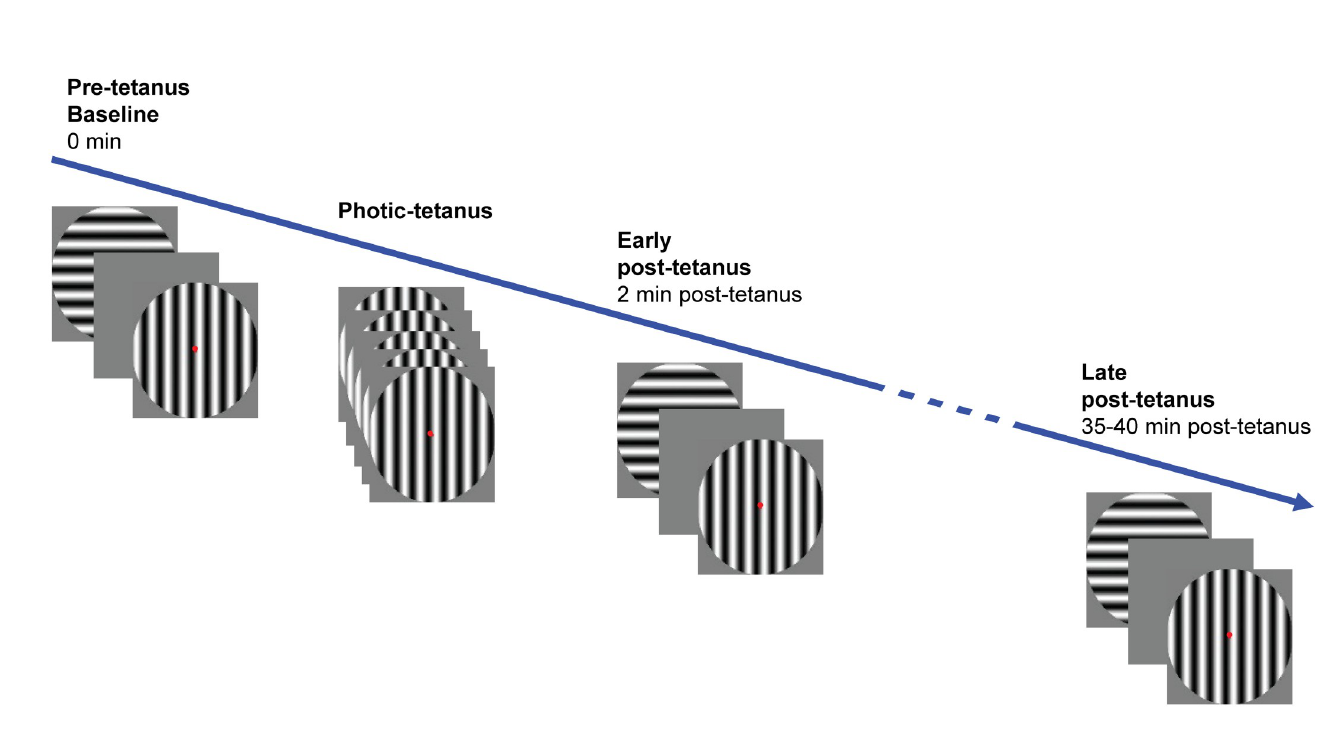
Fig 1. Schematic of the visual LTP